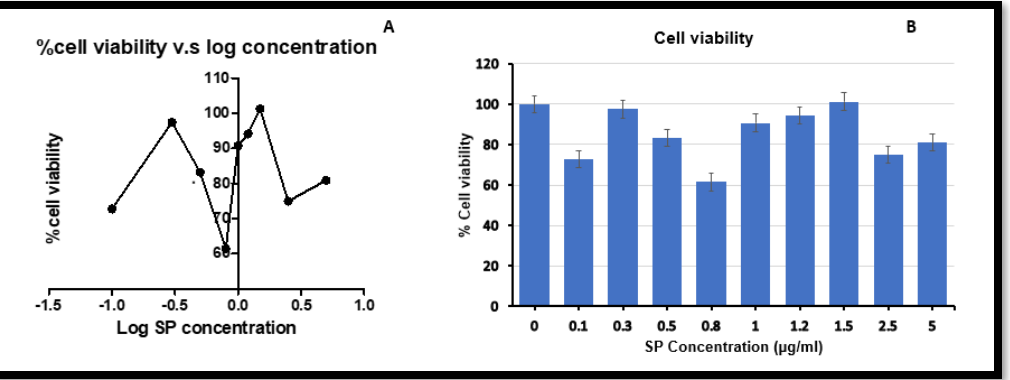
Figure 1. The effects of increased SP treatment concentration on the cell viability in HepG2 cells after 24 h. ( A ) Overall SP increased the cell viability above that of control cells; ( B ) SP concentration of 1.5 µg/mL showed to be more favourable in maintaining cell viability.